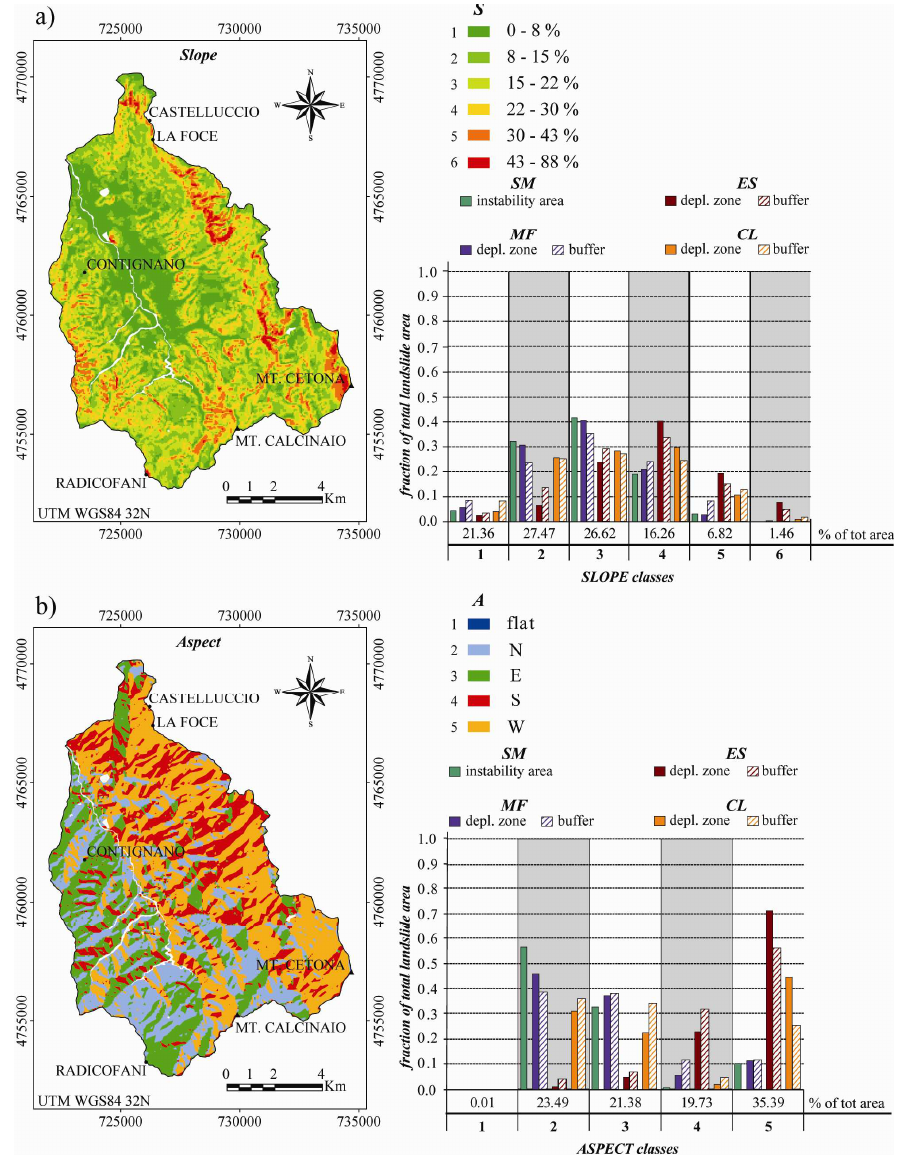
Fig. 6. (a, b) Thematic maps showing the spatial distribution of potential causal factors for landslides: (a) Slope ( S ); (b) Aspect ( A ); (c) Amplitude of Relief (AR); (d) Drainage density ( D ); (e) Land Use (LU); (f) Lithology ( L ). The values of each variable were classified and, for each landslide type, the fraction of the total landslide area within each factor class is reported in the